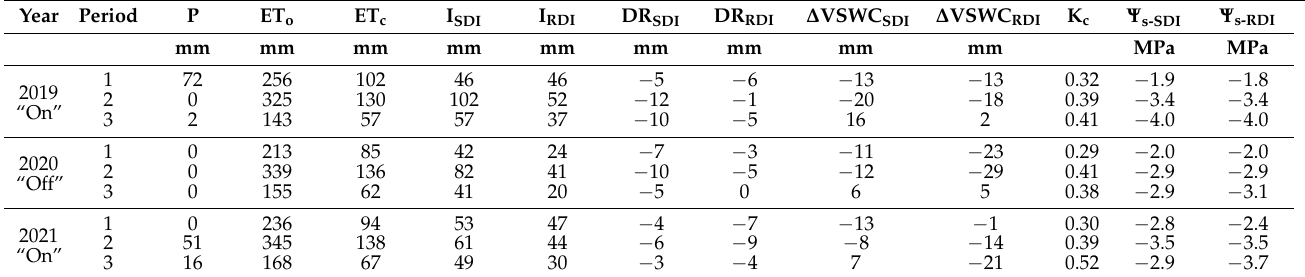
Table 2. Precipitation (P), reference (ET o ) and crop evapotranspiration (ET c , computed with K c = 0.4) irrigation for sustained (I SDI ) and regulated (I RDI ) deficit irrigation treatments, drainage (DR), soil water content change ( ∆ VSWC), computed crop coefficients (K c ) and minimum stem water potential in SDI ( Ψ s-SDI ) and RDI ( Ψ s-RDI ) (average of five replicates) in Periods 1–3 (see Table 1) for